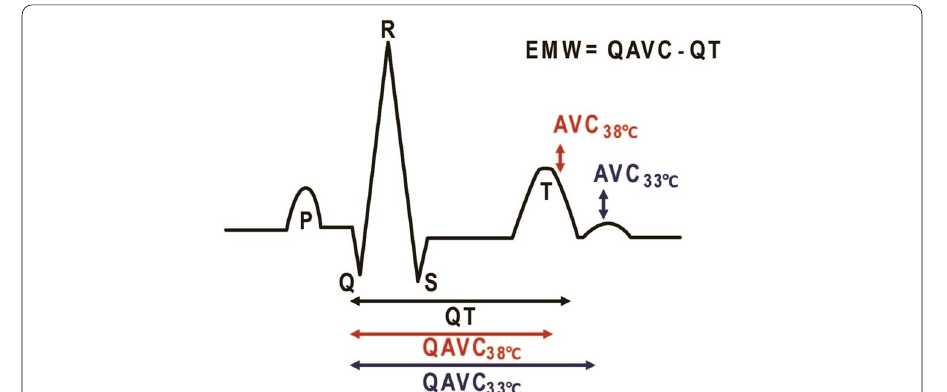
Fig. 1 ECG with remarked echocardiographic timing. A schematic drawing of an ECG signal combined with remarked echocardiographic timing of the aortic valve closure (AVC). QT interval is prolonged at 33° schematic drawing of an ECG si Electromechanical window (EMW) is calculated as EMW